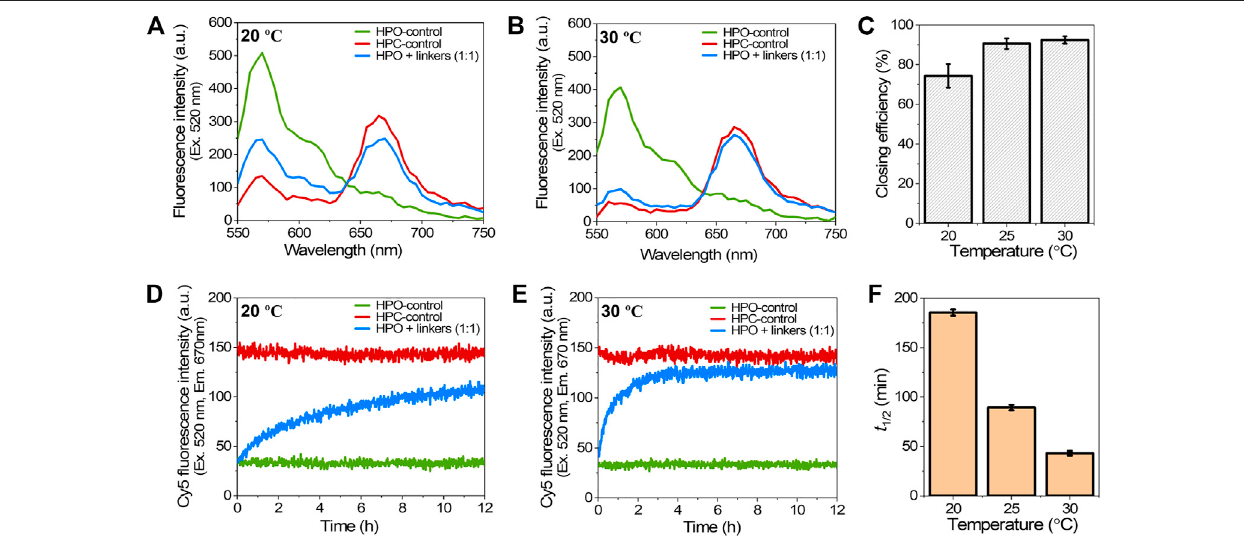
FIGURE4| Effectofthehybridizationtemperatureontheclosingef fi ciencyofDNAscaffold. (A) Fluorescenceemissionspectra( λ ex (cid:2) 520 nm)afterincubationwith 1:1 molarratioofclosing linkers for12 h at20 ° C. (B) Fluorescence emission spectraafter incubation with1:1 molar ratiooftheclosing linkers for12 hat 30 ° C. (C) Effect of the hybridization temperature on closing ef fi ciency at 1:1 molar ratio. (D) Time course changes of the Cy5 fl uorescence intensity ( λ ex (cid:2) 520 nm, λ em (cid:2) 670 nm) during the closing process with1:1 molar ratio ofthe closing linkers at 20 ° C. (E) Time course changesof the Cy5 fl uorescence intensity during the closing process with 1: 1 molar ratio of the closing linkers at 30 ° C. (F) Summary of the half time ( t 1/2 ) of the closing process in (D) , (E) , and Figure 2D . Hybridization conditions: 5 nM HPO was incubated with 5 nM closing linkers in the buffer (pH 7.0) containing 40 mM Tris-HCl, 20 mM acetic acid, 12.5 mM MgCl 2 , and 0.002% Tween20 at the indicated